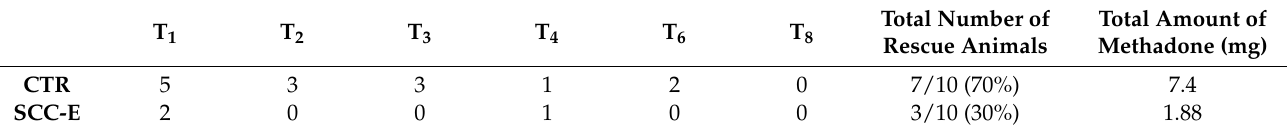
Table 5. Number of analgesic rescues at each postoperative time, receiving methadone IV bolus, whenever the UNESP-Botucatu-MCPS pain scale was ≥ 6 in cats undergoing ovariohysterectomy with (SCC-E group) or without (CTR group) sacrococcygeal epidural (CTR group) ( n = 10 in each